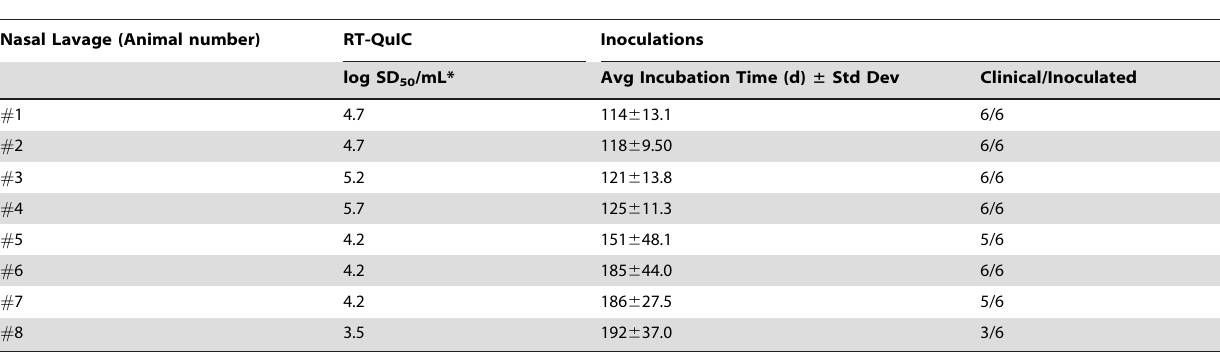
Table 2. HY-TME nasal lavage analyses: comparison of RT-QuIC SD 50 with incubation period in hamsters.